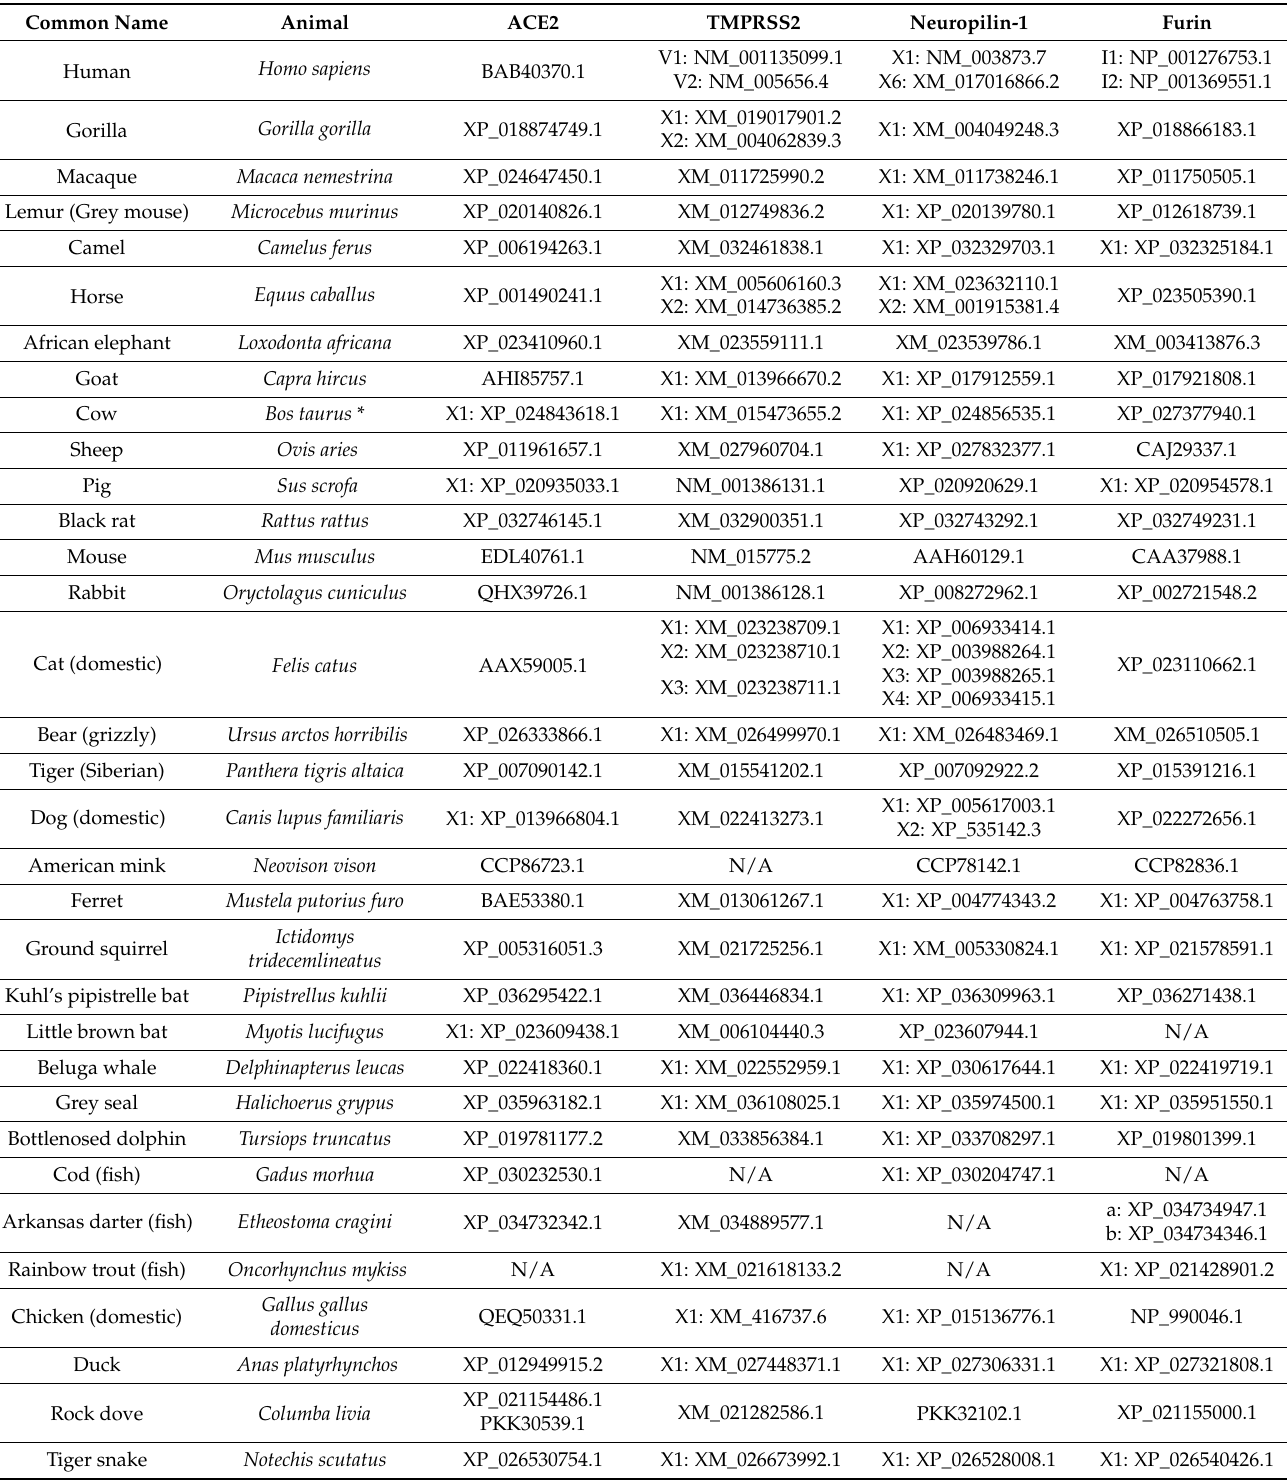
Table 1. Animal species and Accession Numbers of the sequences used for the amino acid alignments shown in the Figures. Data were obtained from The National Center for Biotechnology Information (NCBI). X#, I# or V# indicates the isoforms chosen. N/A: not available from NCBI; * indicates that for the furin sequence this was from a Bos indicus × Bos taurus (hybrid